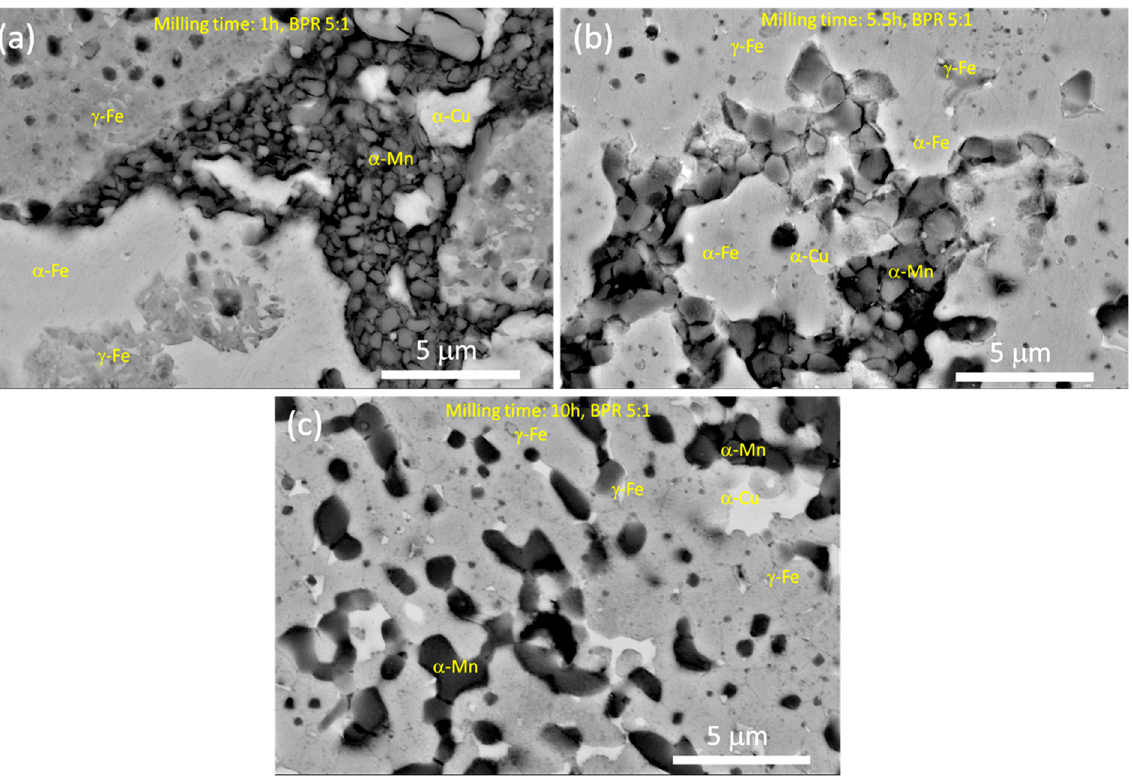
Figure 5. Various phase observations at higher magnification of E-SEM microstructures of FeMn 30 Cu 5 hot-forged biodegradable alloys processed at different milling conditions: ( a ) 1 h with BPR 5:1; ( b ) 5.5 h with BPR 5:1; ( c ) 10 h with BPR 5:1 . ( b ) 5.5 h with BPR 5:1; ( c ) 10 h with BPR